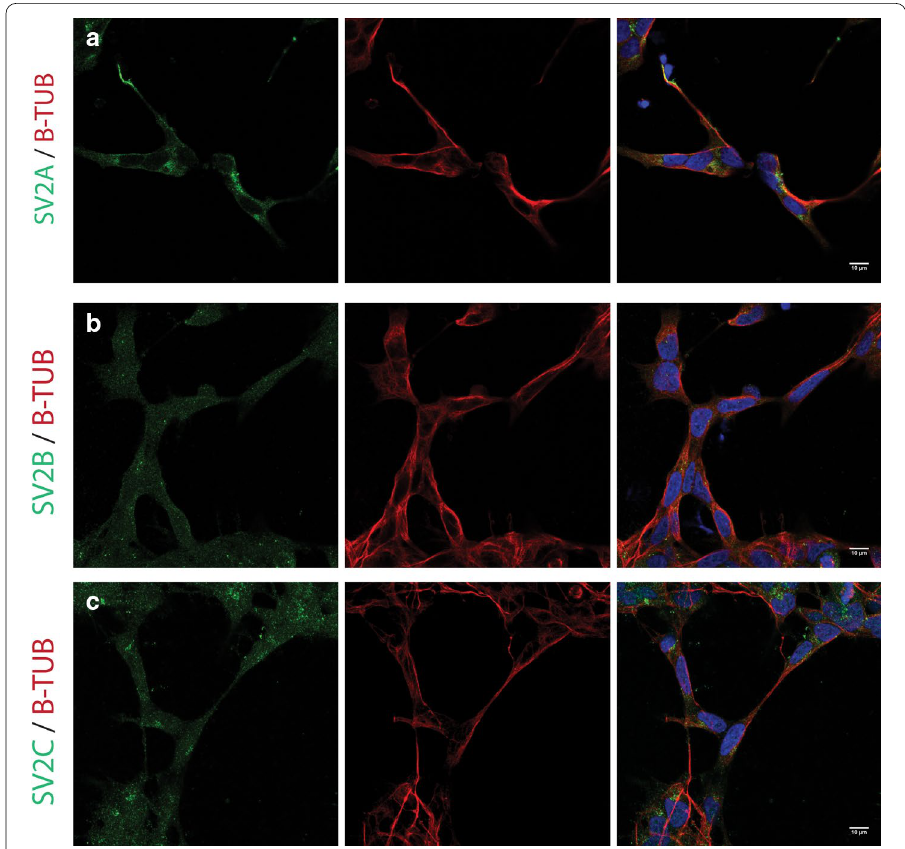
Fig. 2 Immunocytochemistry of IMR-21 cells for SV2 proteins. SV2 isoforms were stained in green, Beta-tubulin in red, nuclear staining using DAPI depicted in blue. Images acquired using confocal microscopy, merged images of six stacks for IMR-32 cells. Scale bar 10 µm. a IMR-32 cells stained for SV2A (green) and B-Tub (red) reveal SV2A staining in projections. b IMR-32 cells stained for SV2B (green) and B-Tub (red) reveal low levels of SV2B staining. c IMR-32 cells stained for SV2C (green) and B-Tub (red) reveal punctuate SV2C staining in some parts of the